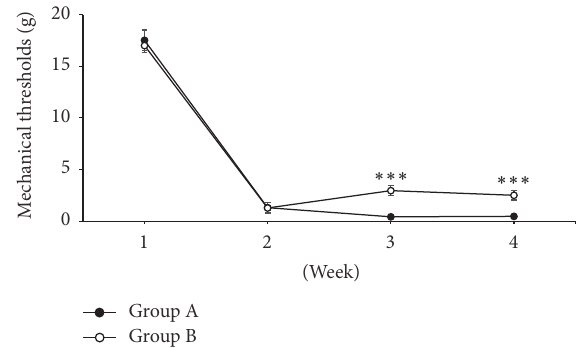
Figure 3: The change of mechanical thresholds was measured every week after pain modeling. Group B showed higher mechanical thresholds compared to Group A at 3rd and 4th weeks, which was statistically significant [two-way analysis of variance (ANOVA) with Bonferroni post hoc tests; ∗∗∗ 𝑝 < .0001 ].